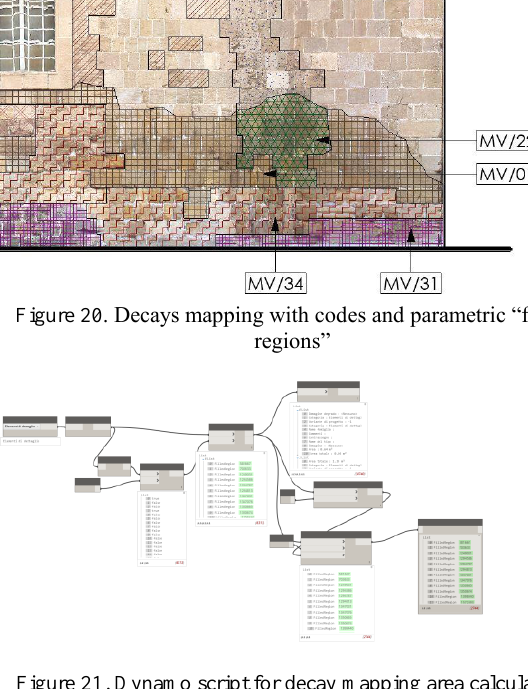
Figure 21. Dynamo script for decay mapping area